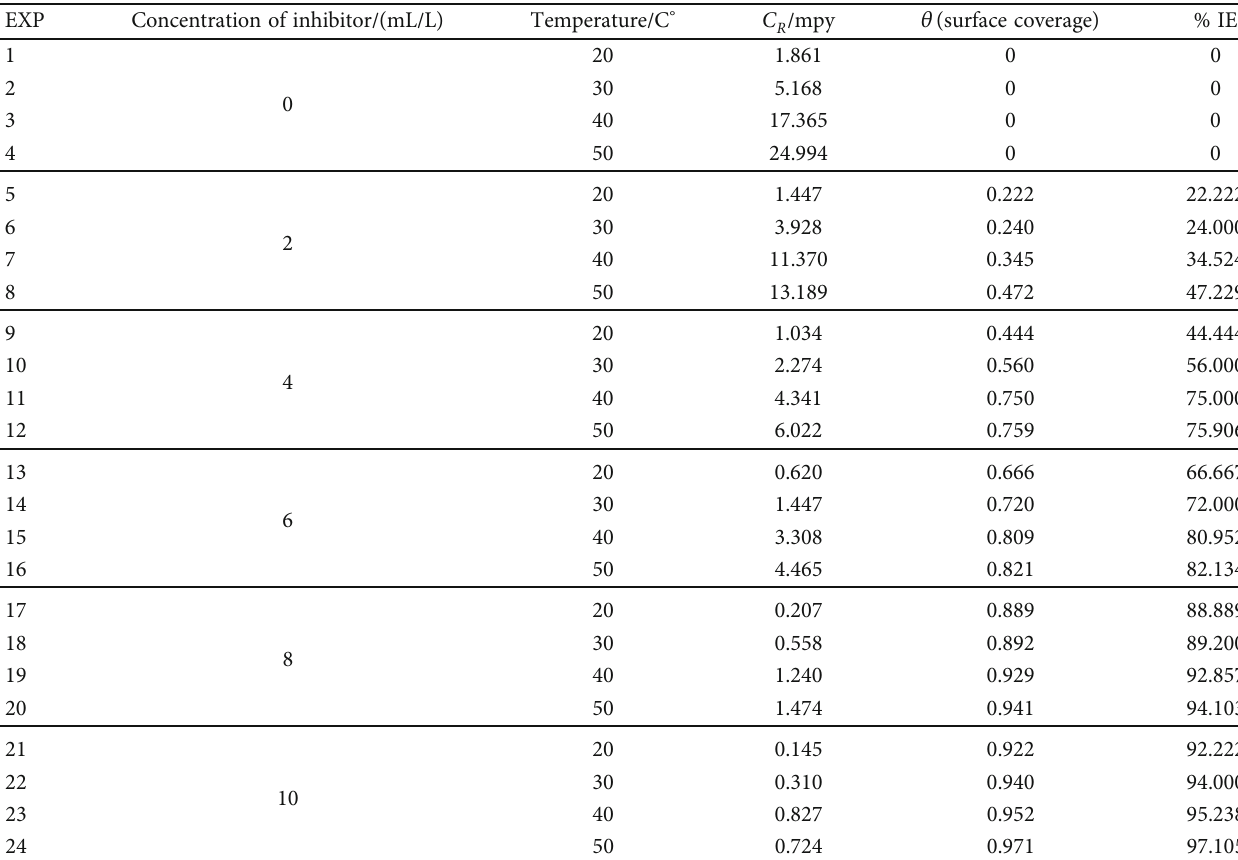
Table 2: E ff ect of inhibitor concentration and temperature on the corrosion behavior of aluminium in hydrochloric acid in the absence and presence of PDL extract as a corrosion